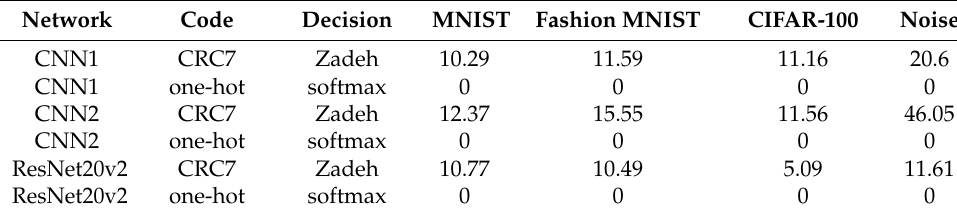
Table 5. Rejection on out-of-distribution datasets with no